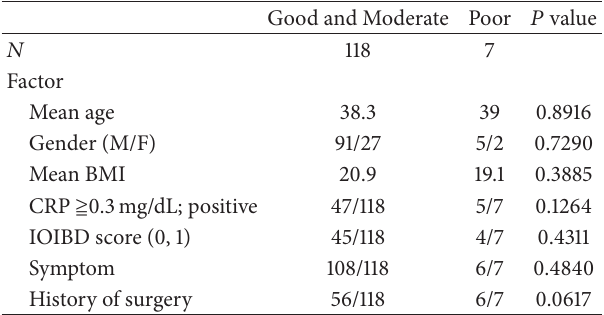
Table8:Comparisonsbetweenthegroupswithsmallbowelstenosis for affecting the category “Poor” on DBE.